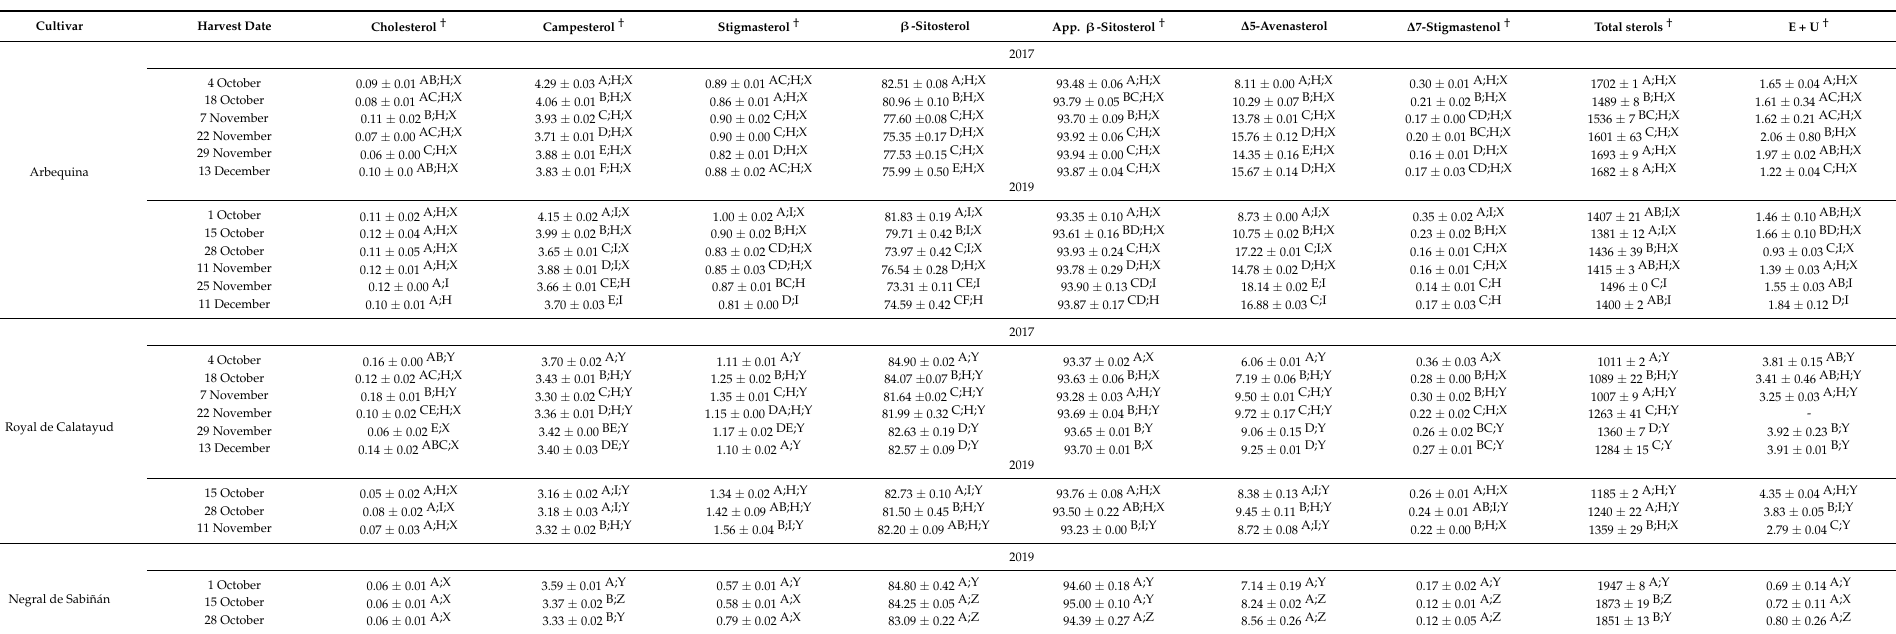
Table 3. Evolution of sterol composition and triterpenic diols according to harvest date for the “Arbequina”, “Royal de Calatayud” and “Negral de Sabiñ á n” olive oils in the 2017 and 2019 crop